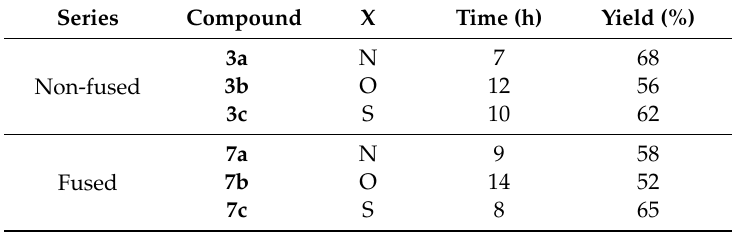
Table 1. Outcome of the cycloaddition reaction of ketones 2 and 6 .